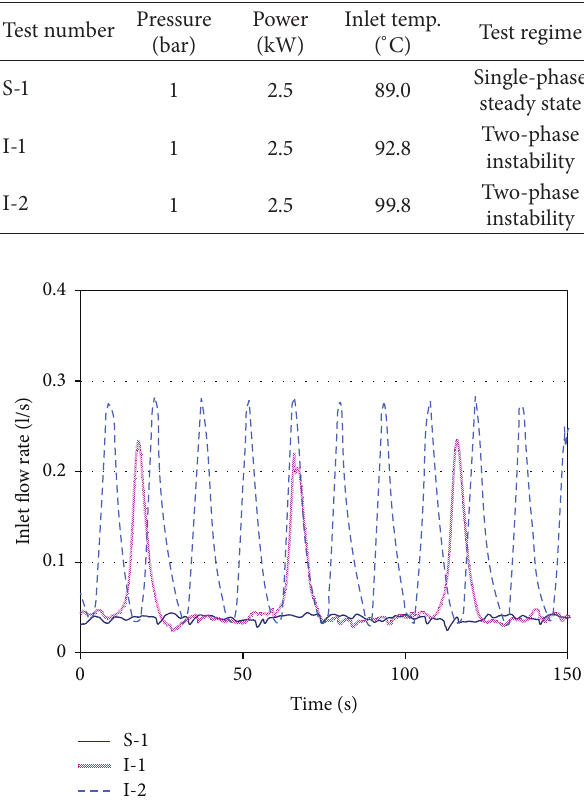
Figure 2: Inlet flow rate in the CIRCUS-IV single channel experi- ments.